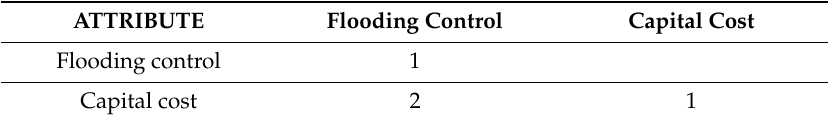
Table A7. Writing example (capital cost is of between equal importance and moderate importance than flooding